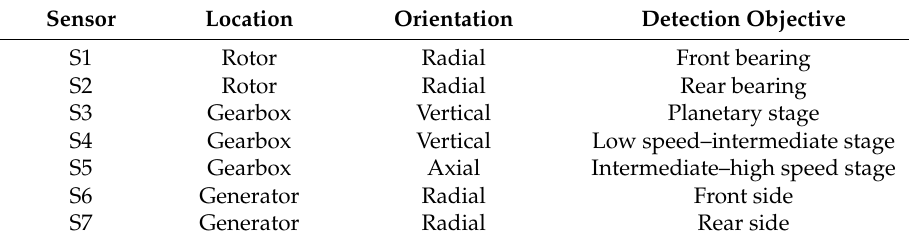
Figure 3. Sensor locations along the drive train. Table 4. Description of the sensor positions and detection objectives.